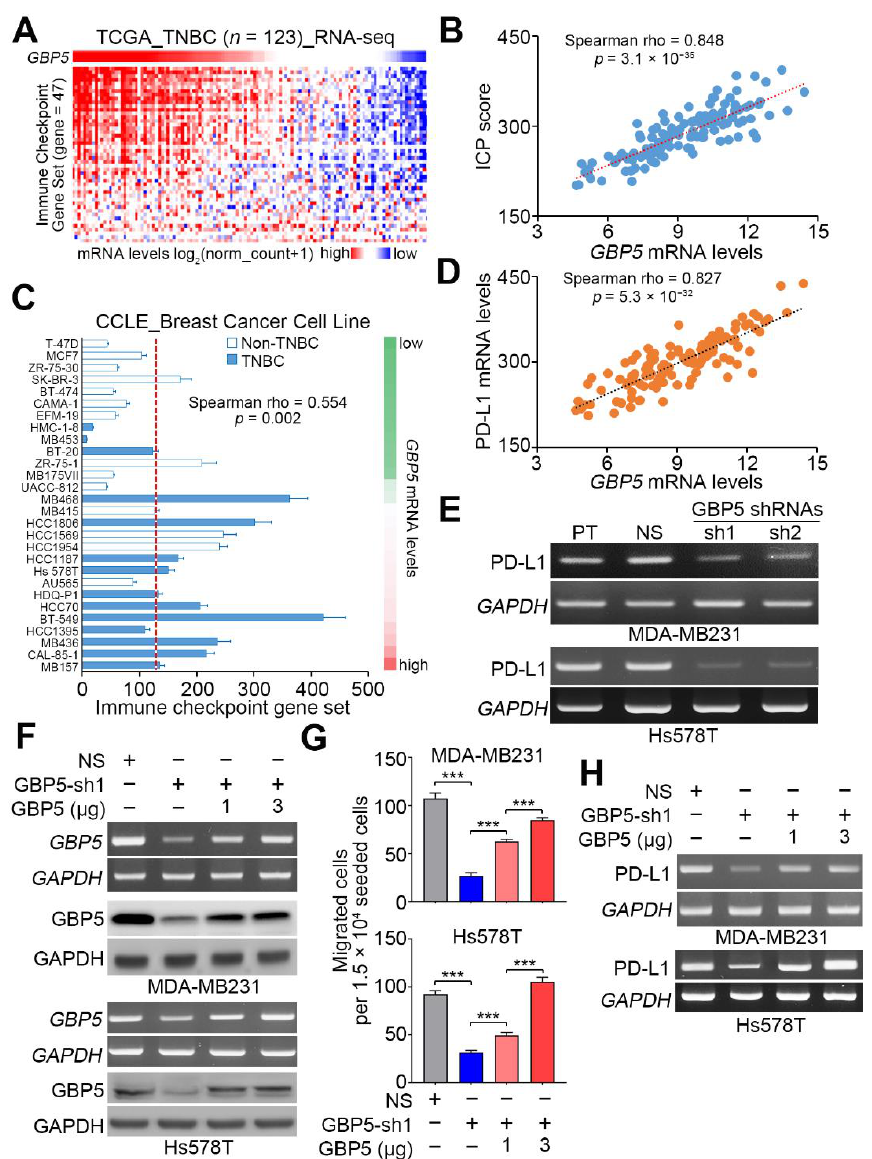
Figure 5. GBP5 knockdown reduces the expression of PD-L1 in TNBC cells. ( A ) Heatmap for the transcriptional profiling of GBP5 and the immune checkpoint (ICP) gene set detected by the RNA-sequencing (RNA-seq) tool in TNBC samples from the TCGA database. ( B ) Scatchard plot for the expression of the GBP5 and ICP gene sets in TNBC samples from the TCGA database. ( C ) Histogram for the expression of the GBP5 and ICP gene sets in the non-TNBC and TNBC cell lines deposited in the GSE36133 dataset. ( D ) Scatchard plot for the expression of GBP5 and PD-L1 in TNBC samples from the TCGA database. In B, C and D, the Spearman correlation test was used to evaluate the statistical significance. In B and D, the dashed lines represent regression line. ( E ) The mRNA levels of PD-L1 and GAPDH detected by RT-PCR in parental (PT) MDA-MB-231 (upper panel)/Hs578T (lower panel) cells and MDA-MB-231/Hs578T cells transfected with nonsilencing (NS) control shRNA or 2 independent GBP5 shRNAs. ( F ) The mRNA and protein levels of GBP5 and GAPDH determined by RT-PCR and Western blotting, respectively, in the NS control and GBP5-sh1-silenced MDA-MB-231 (upper panel) and Hs578T (lower panel) cells without or with the restoration of exogenous GBP5 DNA at 1 and 3 µ g. ( G ) The histograms for the migrated cells in the MDA-MB-231 (upper panel) and Hs578T (lower panel) cell variants as shown in F. The error bars denote the data from three independent experiments presented as the mean ± SEM. A nonparametric Friedman test was used to analyze the statistical significance. The symbol “***” represent p < 0.001. ( H ) The mRNA levels of PD-L1 and GAPDH detected by RT-PCR in the MDA-MB-231 (upper panel) and Hs578T (lower panel) cell variants as shown in ( F ). In ( E , F , H ), GAPDH was used as an internal control of